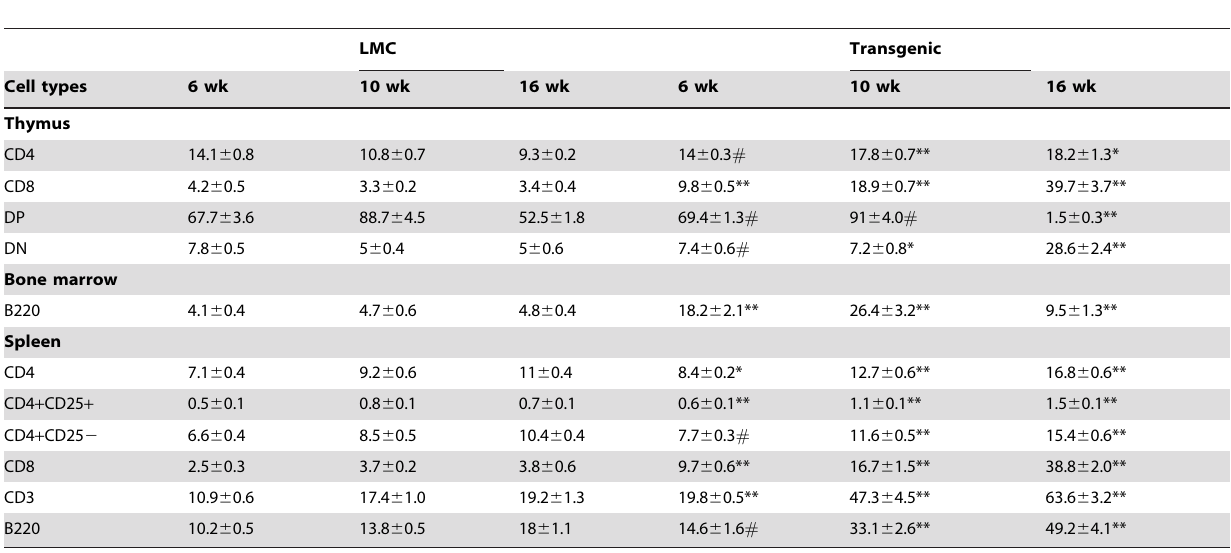
Table 1. Total cell numbers in the thymus, bone marrow and spleen of NOD.Stat5b transgenic mice and littermate